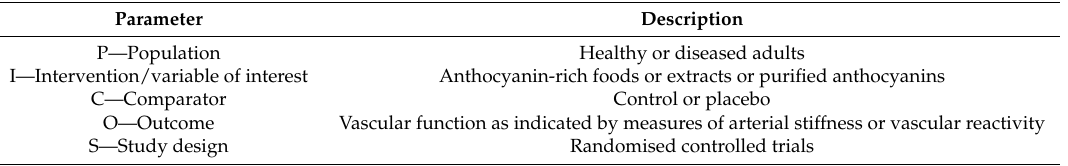
Table 1. Description of the PICOS criteria used to define the research